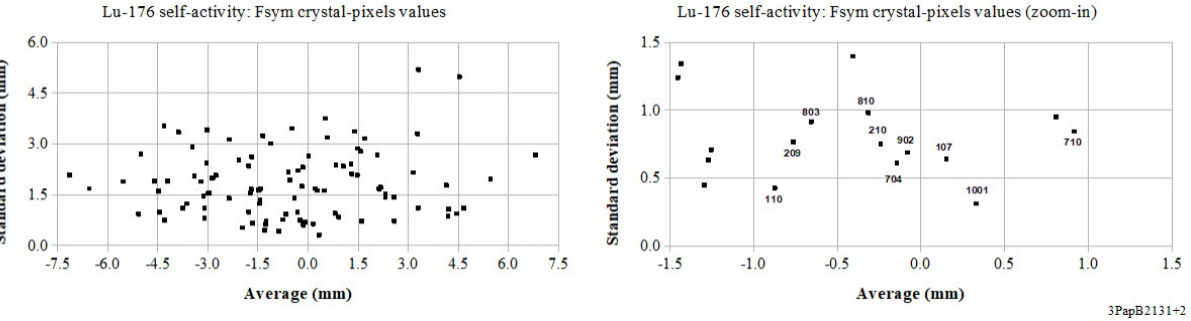
Figure A16. Plot of standard deviation Vs. average of Fsym values ( left ) obtained for all the crystal-pixels of the 10 × 10 array under Cs-137 irradiation. A relevant overall dispersion of results is shown, suggesting to search for a subset of pixels showing the most similar symmetry properties. Zoom-in ( right ) of the central-zone of the plot on the left, showing the decuple of pixels with the smaller charge-spread values around the origin. The selected decuple was, in RRCC ascending order, 103, 104, 107, 110, 704, 710, 803, 810, 902, and 1001 with distance-values from origin ranging from 0.37- to 1.09-mm.